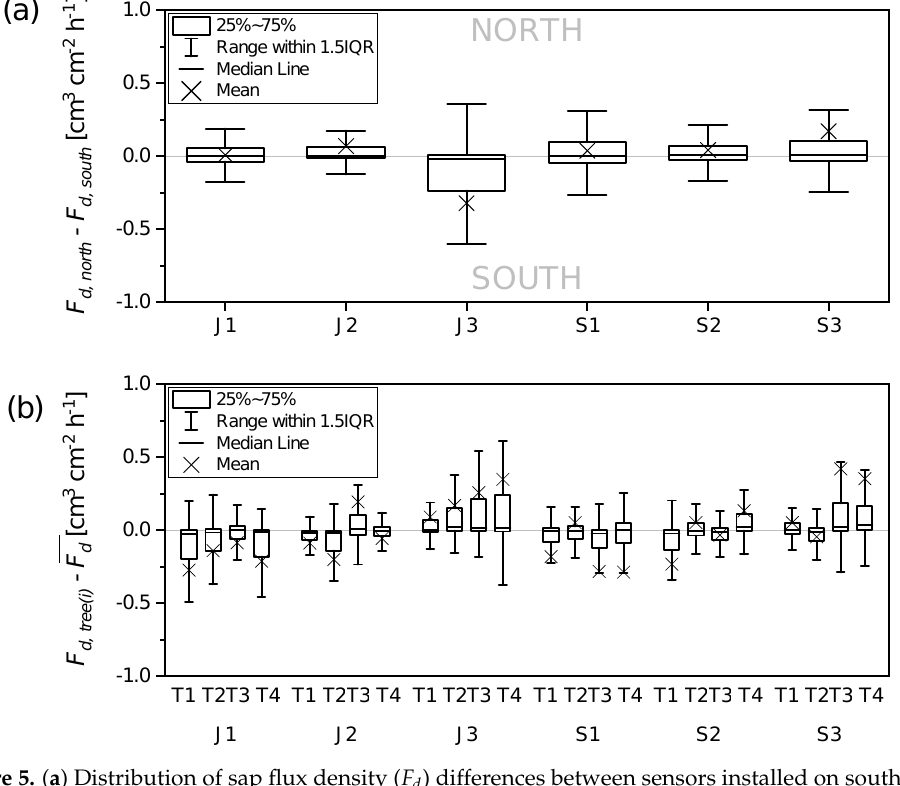
Figure 5. ( a ) Distribution of sap flux density ( F d ) differences between sensors installed on south and north sides of the tree; and ( b ) tree-to-tree variations described by the deviation of each tree F d from the site mean F d . The variability is described by the interquartile range (IQR). Letters on the x -axis refer to tree (T), Juvenile (J) and Sapling (S), and followed by the tree or plot